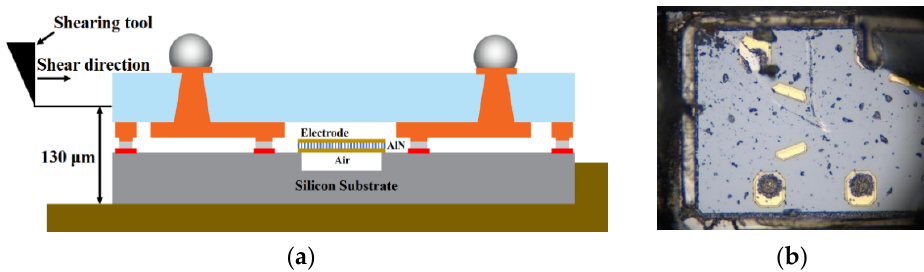
Figure 13. The scheme and fracture section of the die shear test scheme. ( a ) Shear strength measuring scheme; ( b ) The view of fracture after the die shear test.